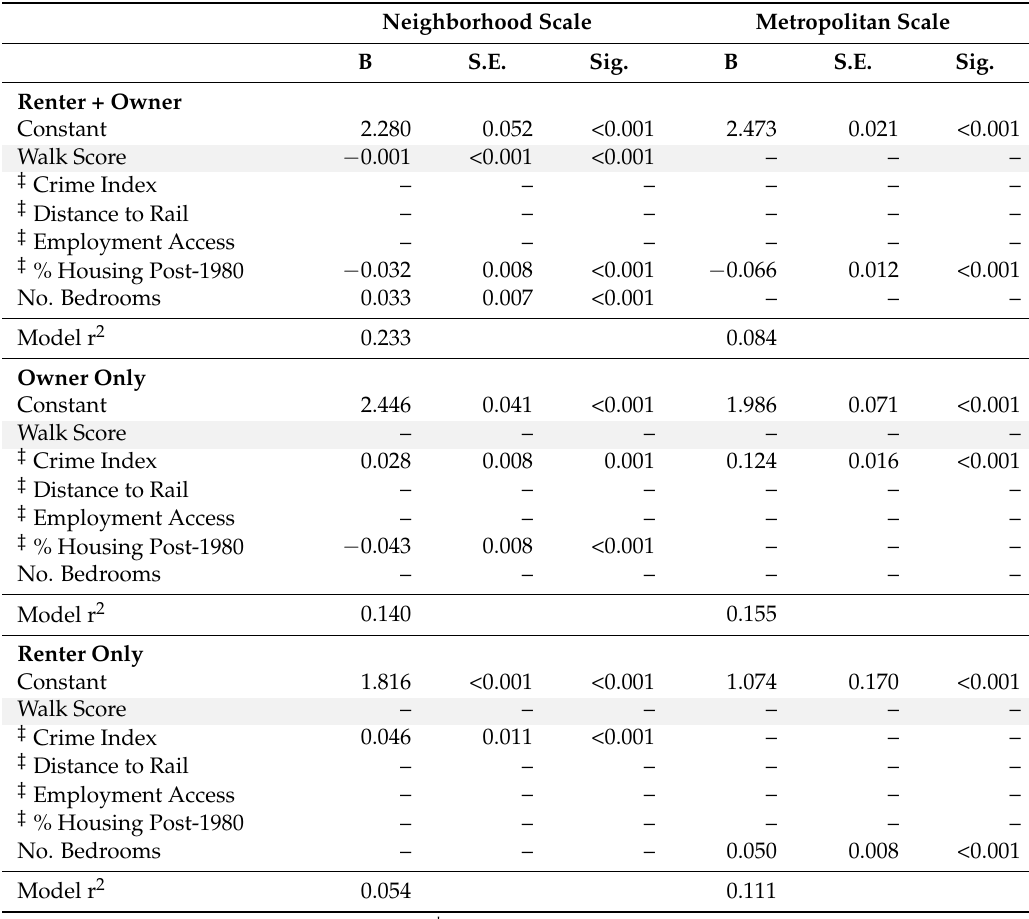
Table 3. Results of the OLS regression analyses (stepwise procedure) for the Pittsburgh, PA urbanized area, with the log(10) of the combined renter and owner (CHAI), owner only (HAI), and renter only (RAI) housing affordability indices as the dependent